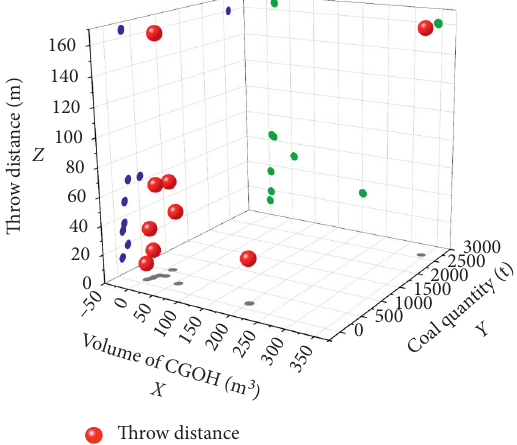
Figure 16: 3D scatter diagram of CGOH volume, coal quantity, and throw distance and its projection on three planes ( XYZ